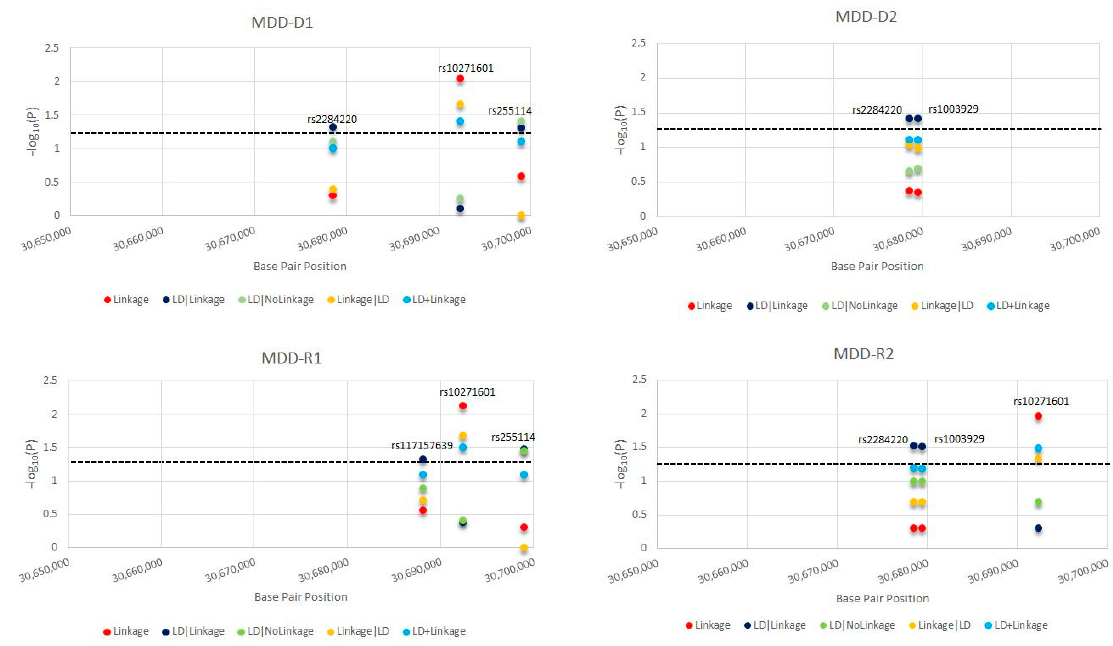
Figure 1. Major depressive disorder (MDD) CRHR2 -Risk Single Nucleotide Polymorphisms (SNPs). For each CRHR2 -risk SNPs in MDD, we present the − log 10 (P) as a function of each test statistic